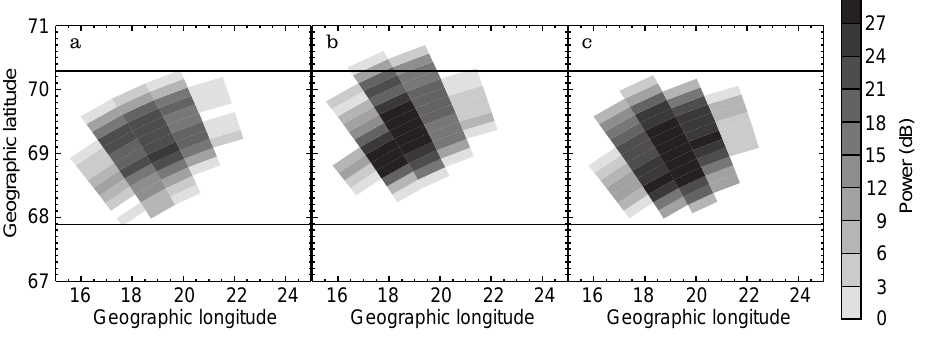
Fig. 10a–c. CUTLASS Finland spatial plots for 22 April 1996. a 1447UT, heater beam at (cid:255) 13 (cid:14) to the vertical. b 1504UT, heater beam pointing vertically. c 1534UT, heater beam at (cid:255) 13 (cid:14) to the vertical. Horizontal lines are drawn at 67 : 9 (cid:14) and 70 : 3 (cid:14)